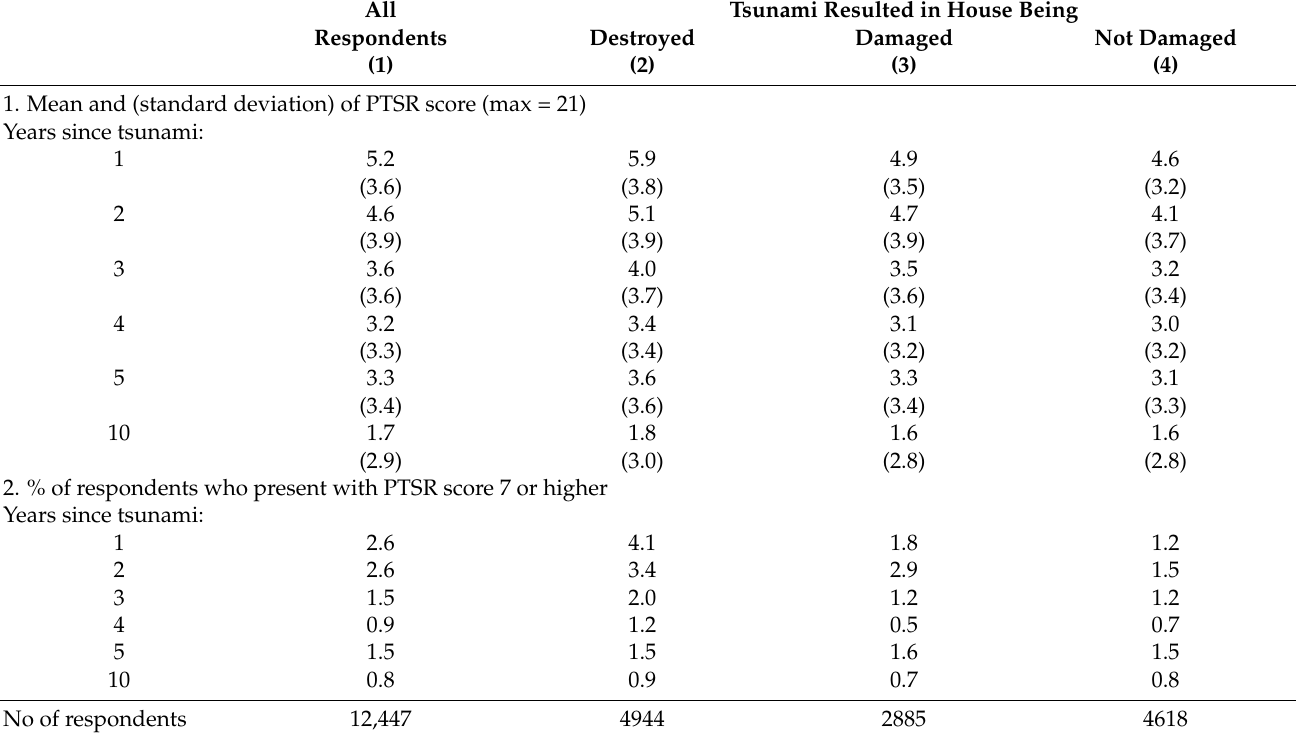
Table 3. PTSR by tsunami-related housing damage and years since